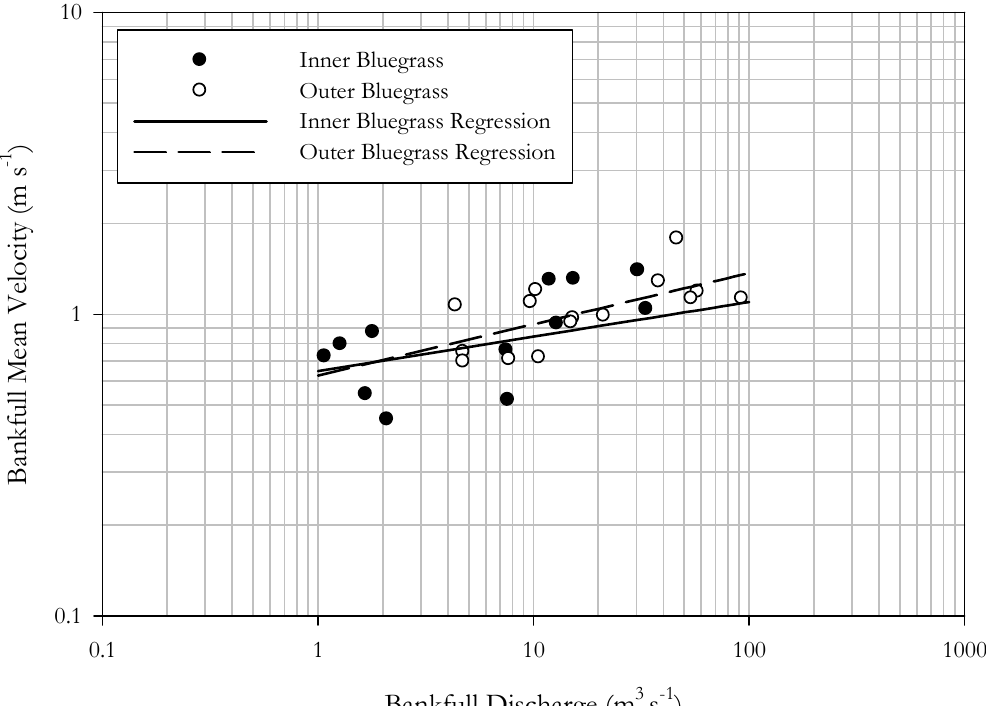
Figure 8. Bankfull mean velocity vs . bankfull discharge for the Inner Bluegrass and Outer Bluegrass